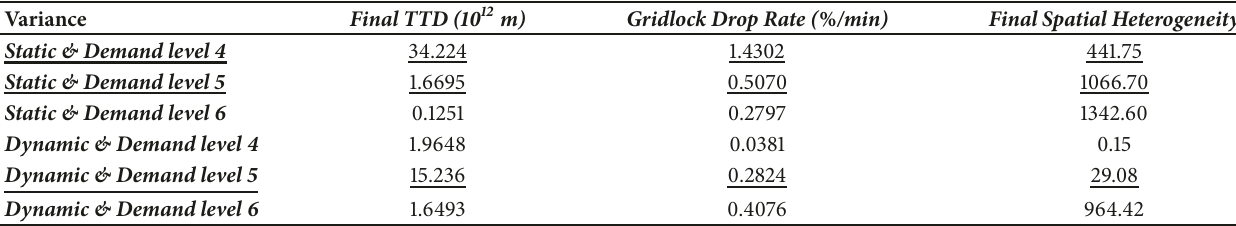
Table 1: Distribution indicators for the main network performance